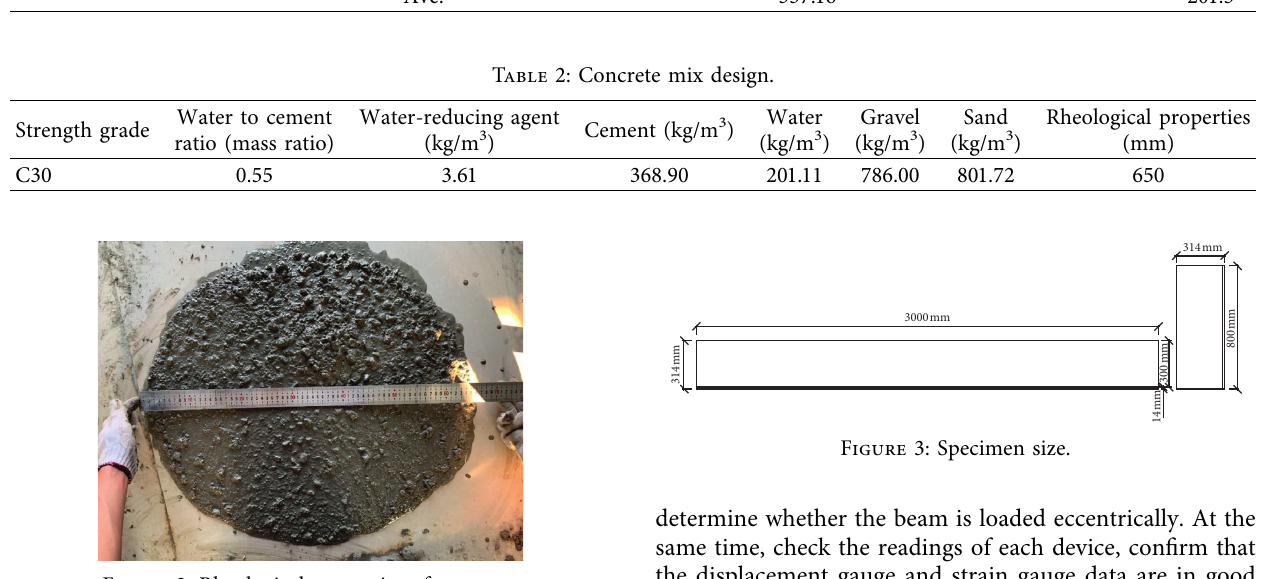
Figure 2: Rheological properties of concrete. Table 3: Concrete strength.